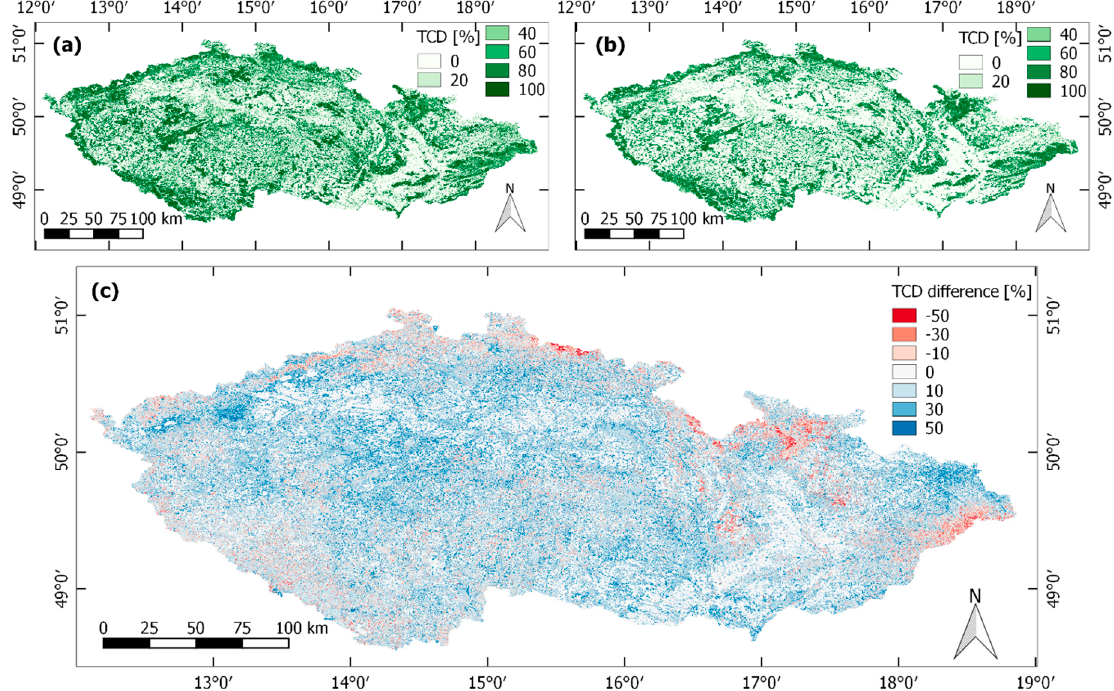
Figure 13. Detailed tree cover density (TCD) maps of the Czech Republic from ( a ) Sentinel-1, ( b ) Copernicus High Resolution Layers (HRL) and ( c ) the difference map between the two datasets (Copernicus HRL map was subtracted from Sentinel-1 TCD map).